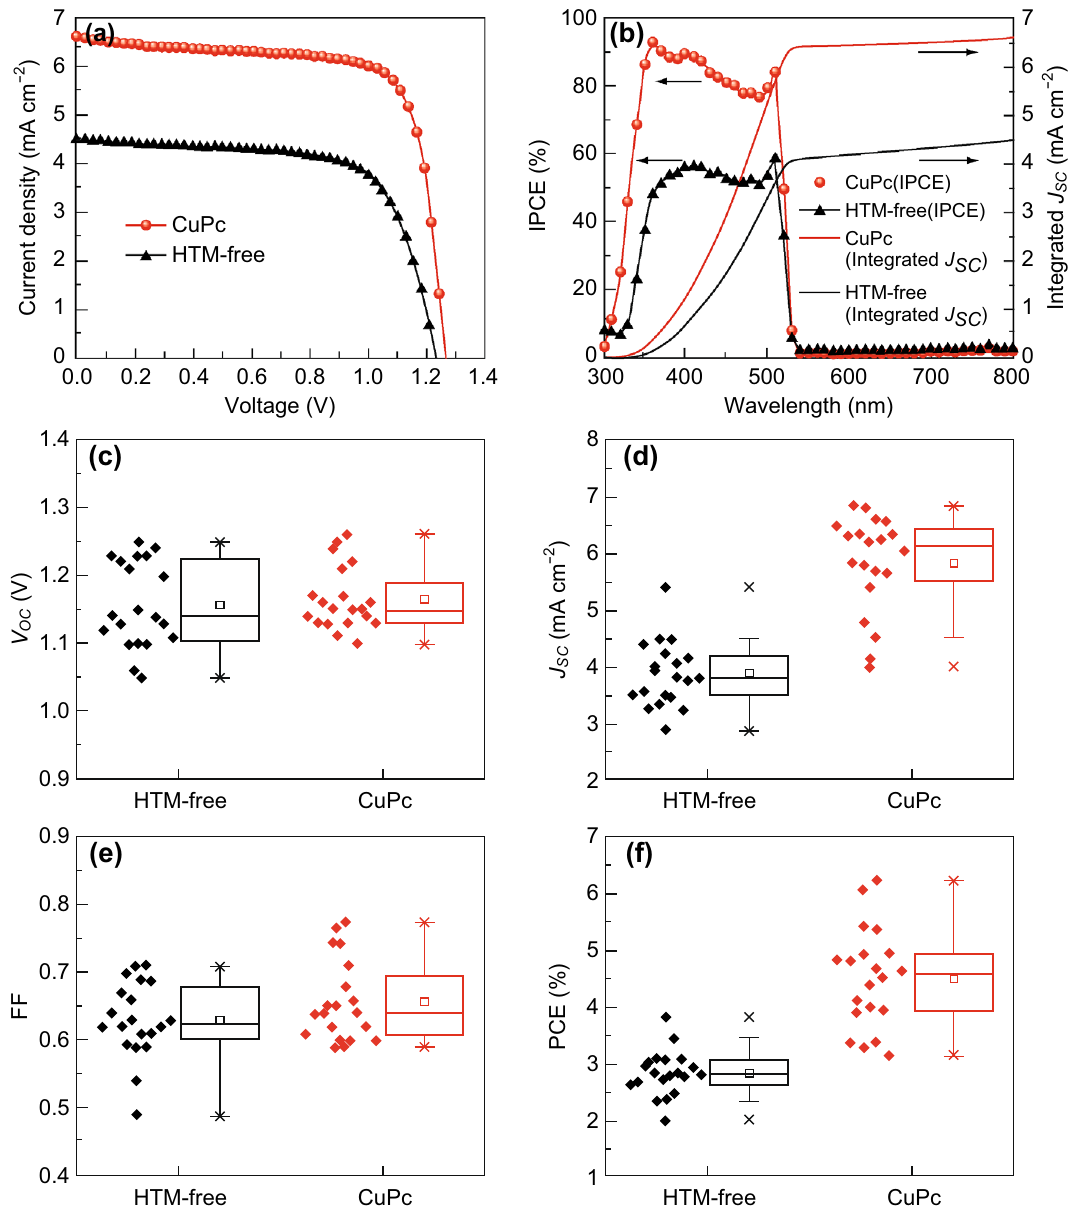
Fig. 4 a Best performed current density–voltage ( J – V ) curves of typical small-area (0.071 cm 2 ) carbon-based CsPbBr 3 PSCs with CuPc as HTM or without HTM measured under 100 mW cm - 2 photon flux (AM 1.5G), respectively. b IPCE spectra and corresponding integrated photocurrents. Box charts exhibiting the statistical features of c J SC , d V OC , e FF, and f PCE of the carbon-based CsPbBr 3 PSCs with CuPc as HTM or without